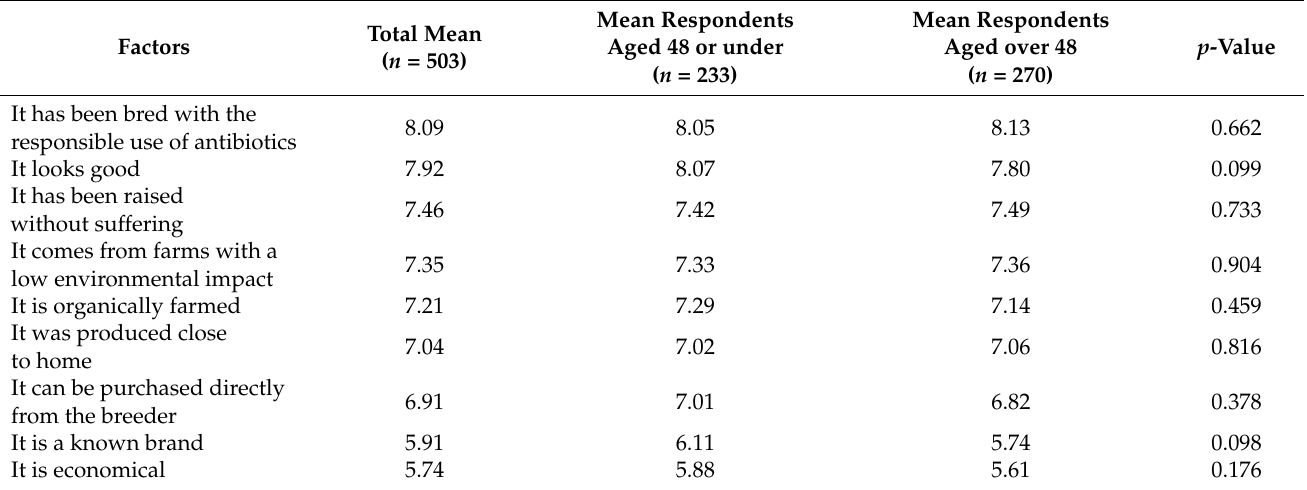
Table 5. Factors that drive consumers’ choice in purchasing rabbit meat. Likert scale 1–10, results of the t -tests.